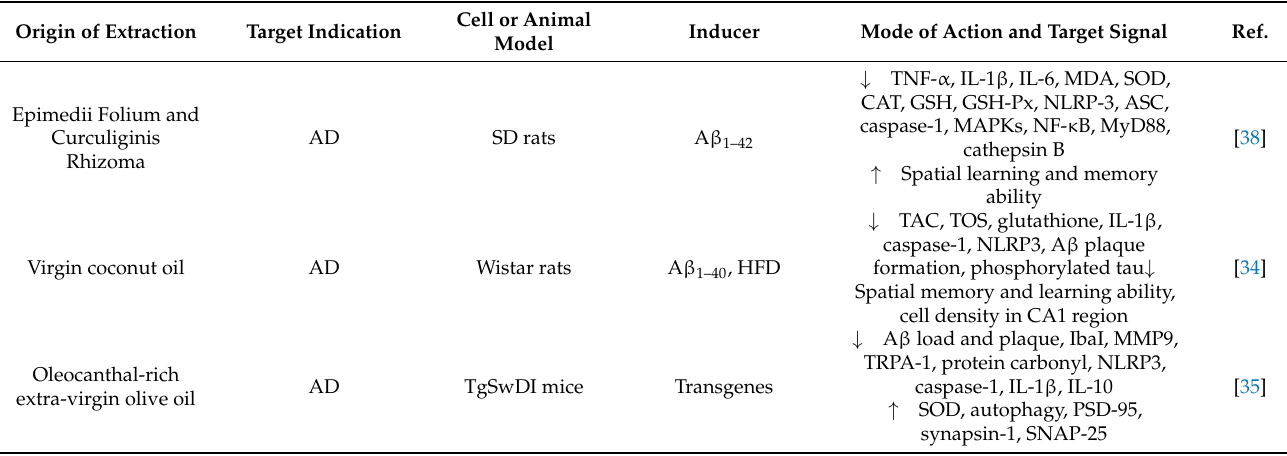
Table 1. NLRP3 inflammasome targeting study of natural extraction in Alzheimer’s disease (AD) and Parkinson’s dis- ease